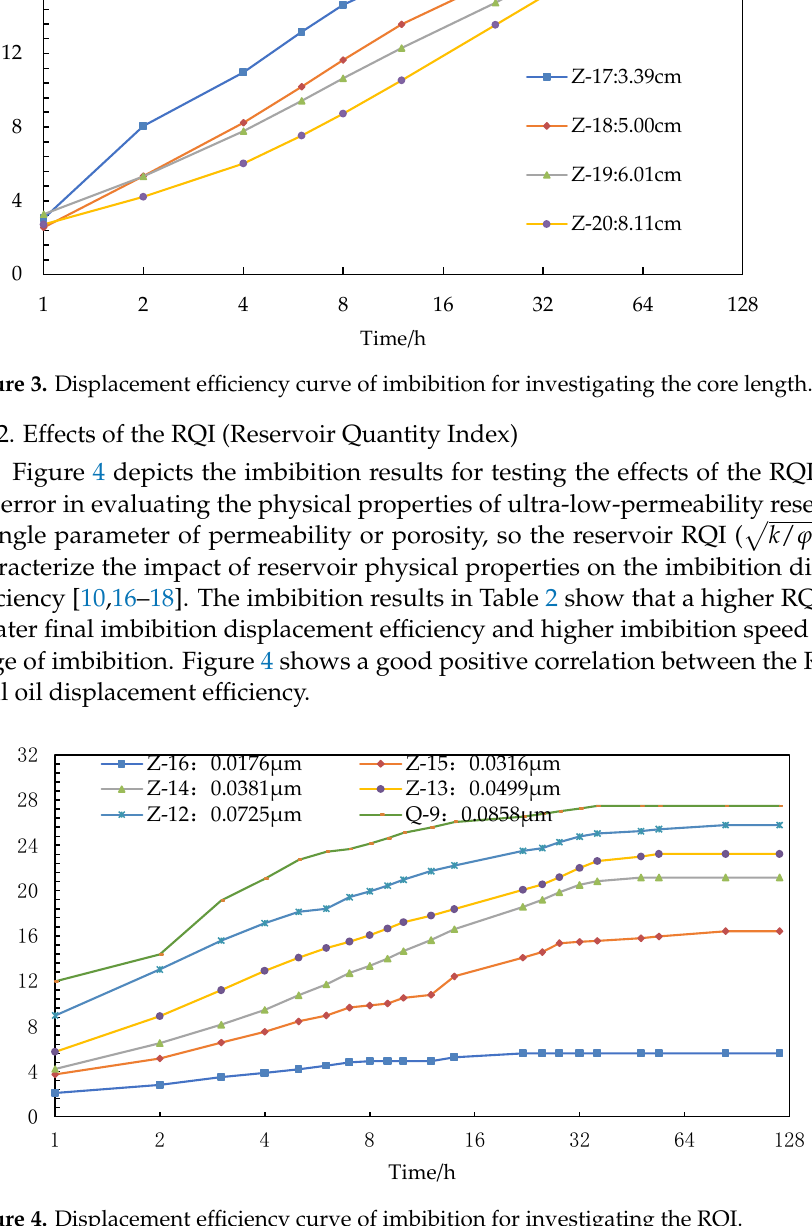
Figure 4. Displacement efficiency curve of imbibition for investigating the RQI.